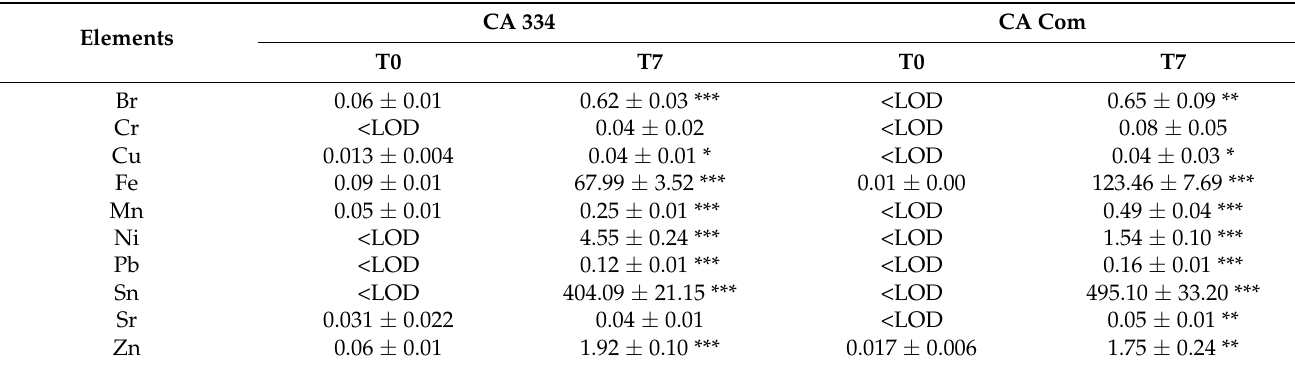
Table 2. Concentration (mg/L) of representative leachates generated by a citric acid (CA) solution produced by Aspergillus niger NRRL 334 (CA 334) and by a commercial CA (CA Com) (10.65 mM) at the beginning (T0) and after 7 days (T7) of mouse circuit boards soaking. Data represent average concentrations from three independent TXRF measures ±